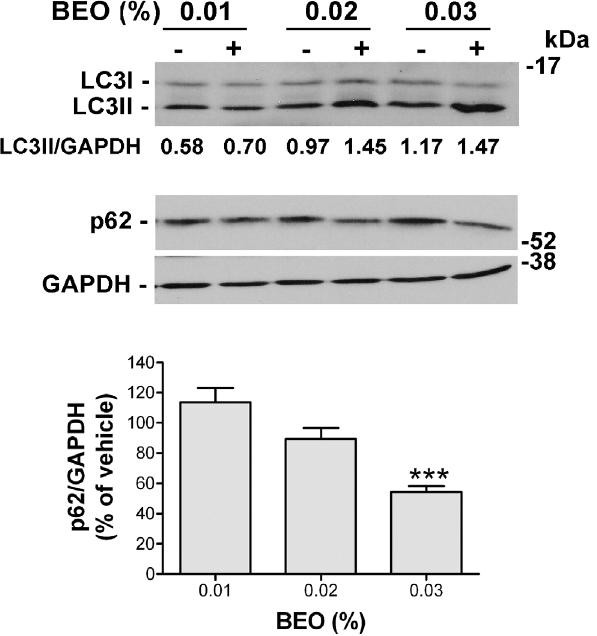
Figure 5. BEO activates autophagy in MCF7 cells. Representative immunoblot showing LC3I to LC3II conversion and reduced p62 levels following exposure of MCF7 cells to increasing concentrations of BEO. Cells were incubated with medium containing either vehicle (ethanol, 0.009–0.027%) or BEO (0.01–0.03%) for 1 h. GAPDH was used as loading control. LC3II/GAPDH optical density (OD) ratio for the reported blot is shown. Histogram shows the results of densitometric analysis of p62 levels normalized on GAPDH values and expressed as percentage of vehicle from three independent experiments (mean ¡ s.e.m.). ***P , 0.001 vs vehicle (Student’s t